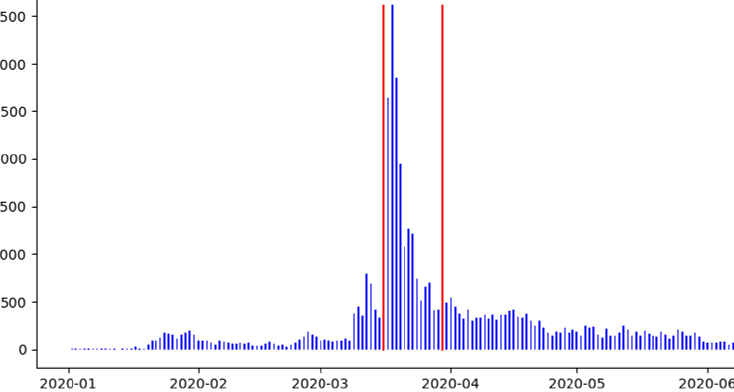
Figure 1. Daily count of tweets containing “Chinavirus”. The red vertical lines denote the period 16 March through 31 March 2020 when the phrase “Chinavirus” and its variants were used by the White House.